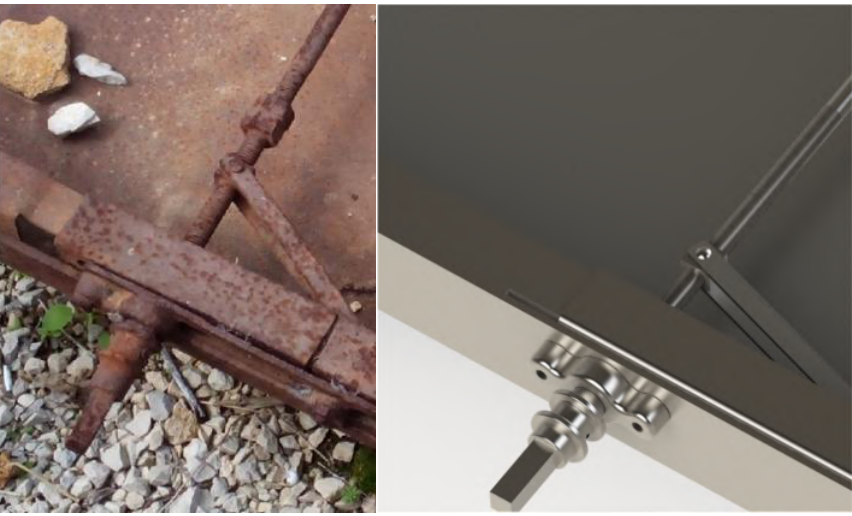
Figure 14. Conveyor-belt tensioning system ( left ) and 3D CAD model ( right ).